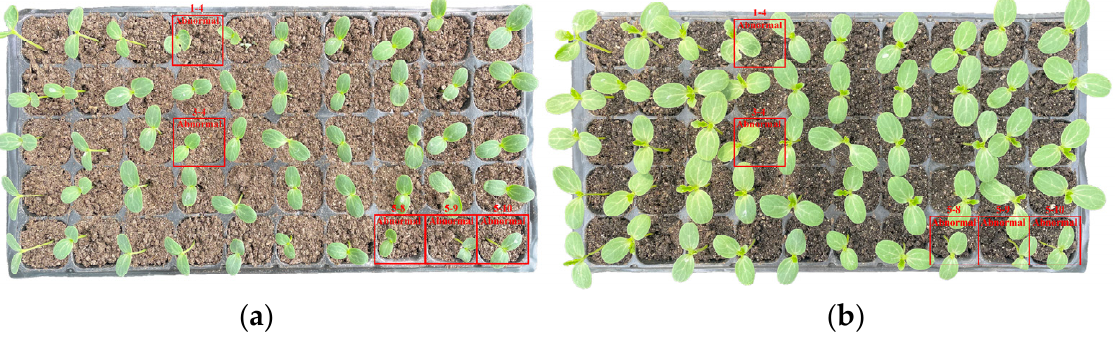
Figure 15. Abnormal seedling detection results. ( a ) Day 3 abnormal seedling detection. ( b ) Day 6 abnormal seedling detection.